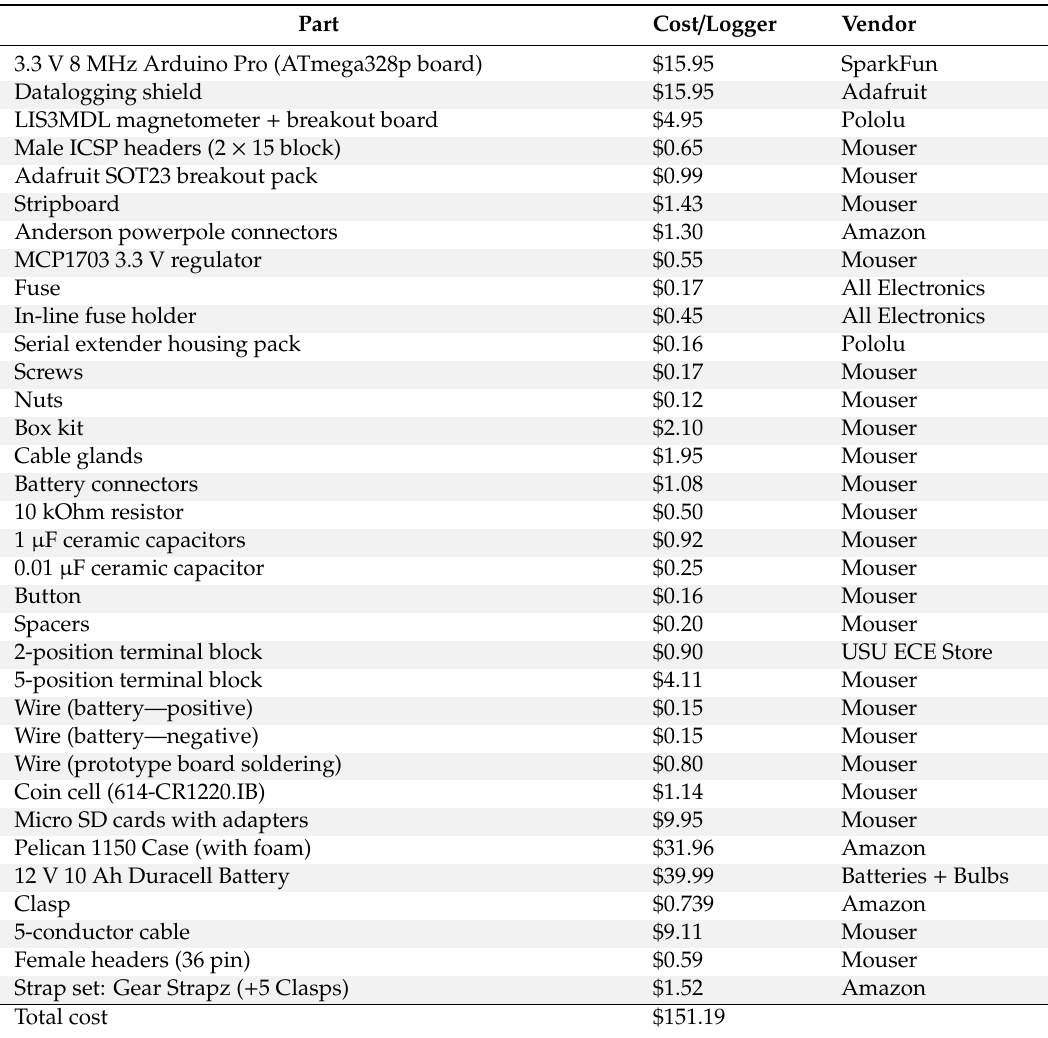
Table 1. Parts required and costs to build a Cyberinfrastructure for Intelligent Water Supply (CIWS)